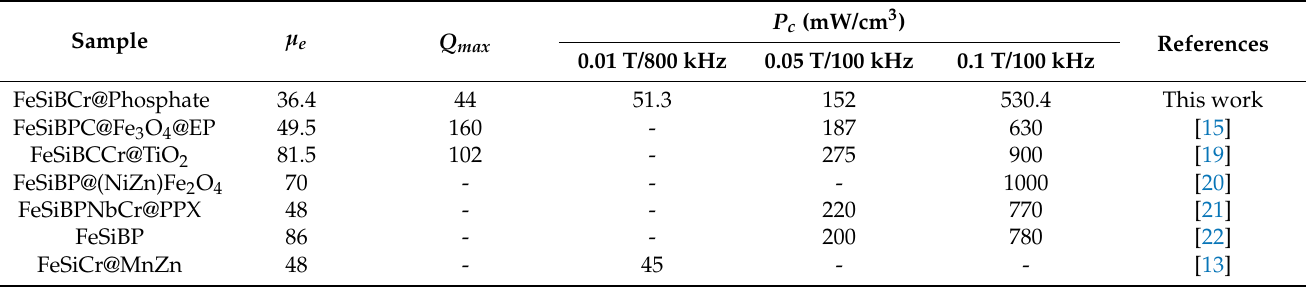
Table 1. The core loss of the samples and other research in the